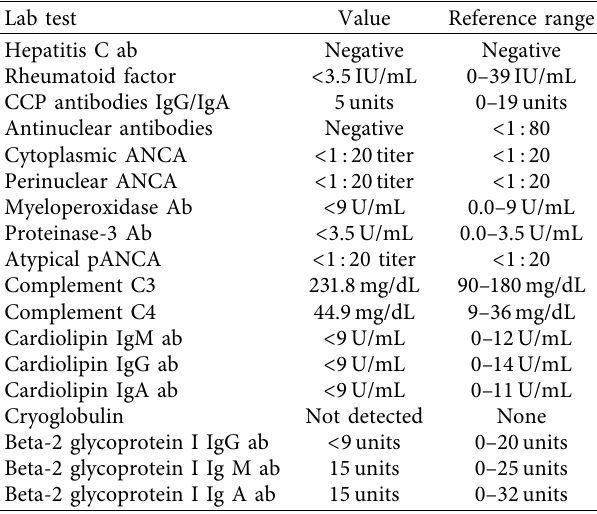
Table 2: Additional laboratory testing